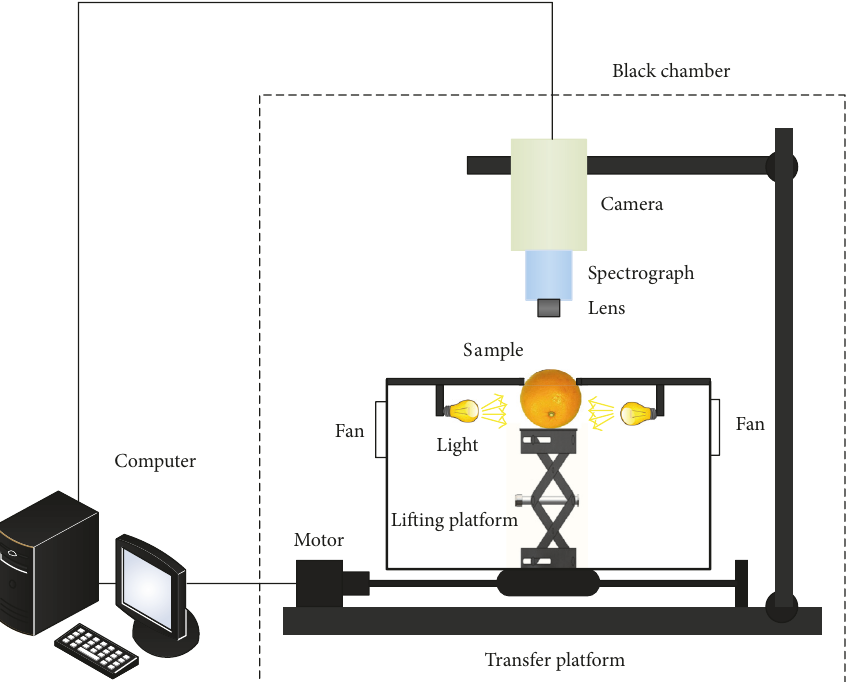
Figure 1: Schematic diagram of the used diffuse transmittance hyperspectral imaging system for navel oranges maturity classification.